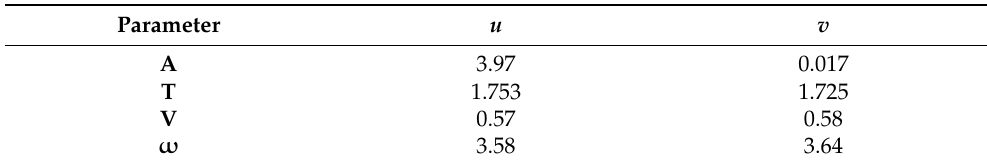
Table 2. The parameters obtained during the study of periodic generation, where A is the voltage amplitude (B), T is the oscillation period (second), V is the frequency (Hz), and ω is the natural frequency (second − 1 )